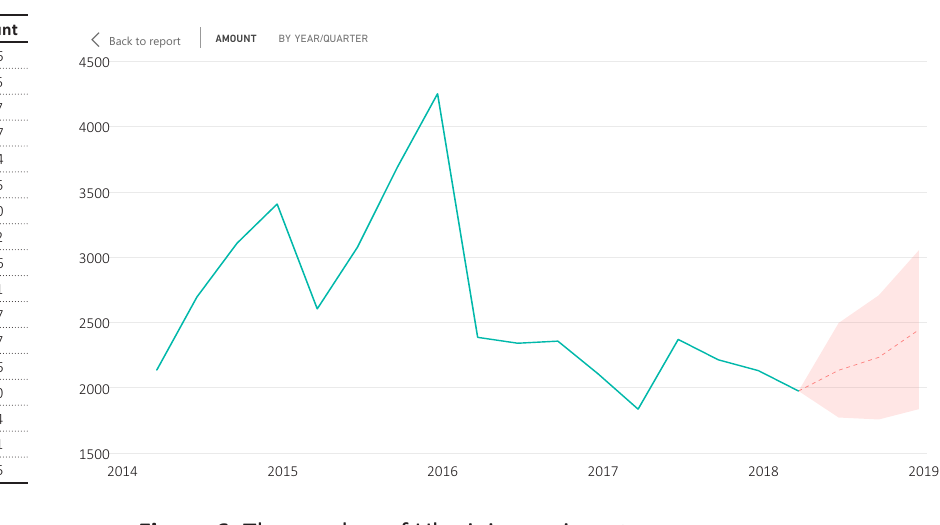
Figure 6. The number of Ukrainian emigrants and visualization the forecasting process in Power